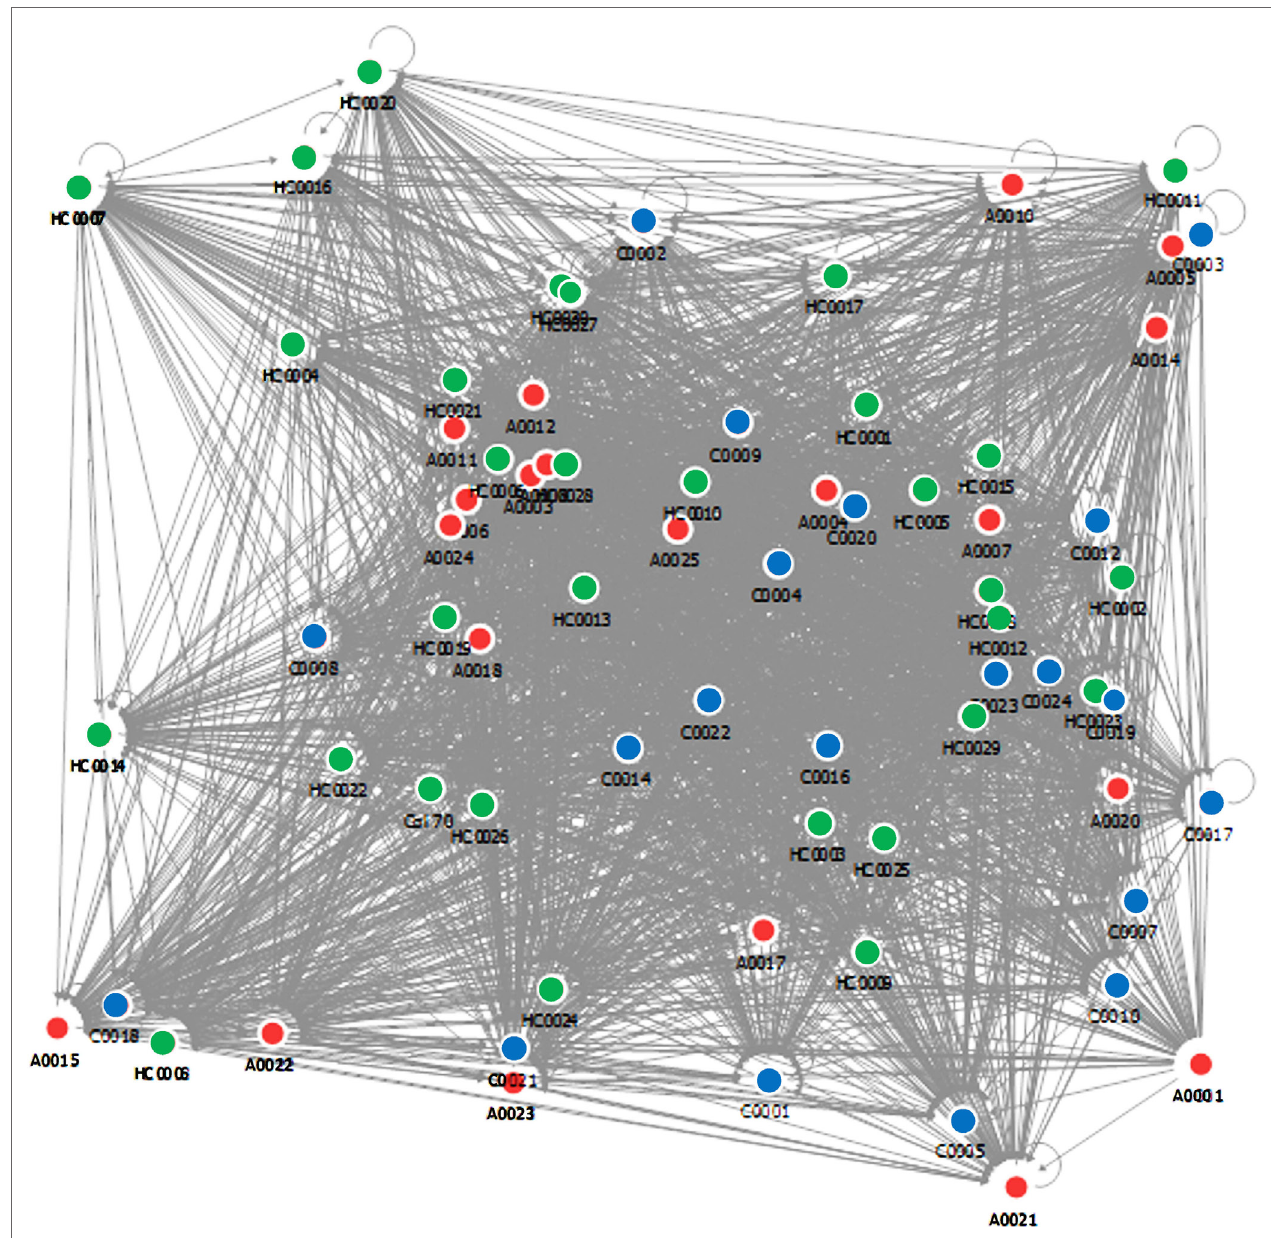
FigUre 4 | Vector diagram of the steroid ratio